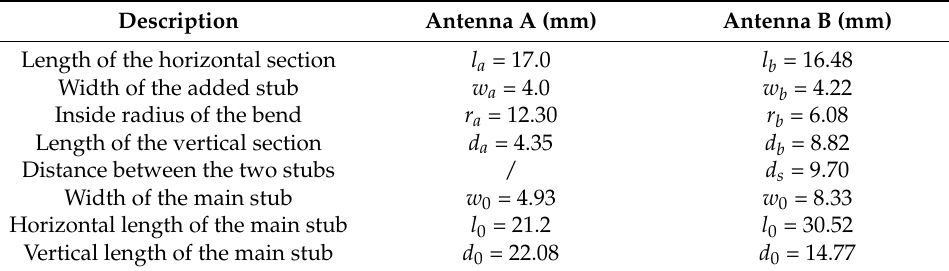
Table 1. Optimal structural parameters of the proposed antennas.